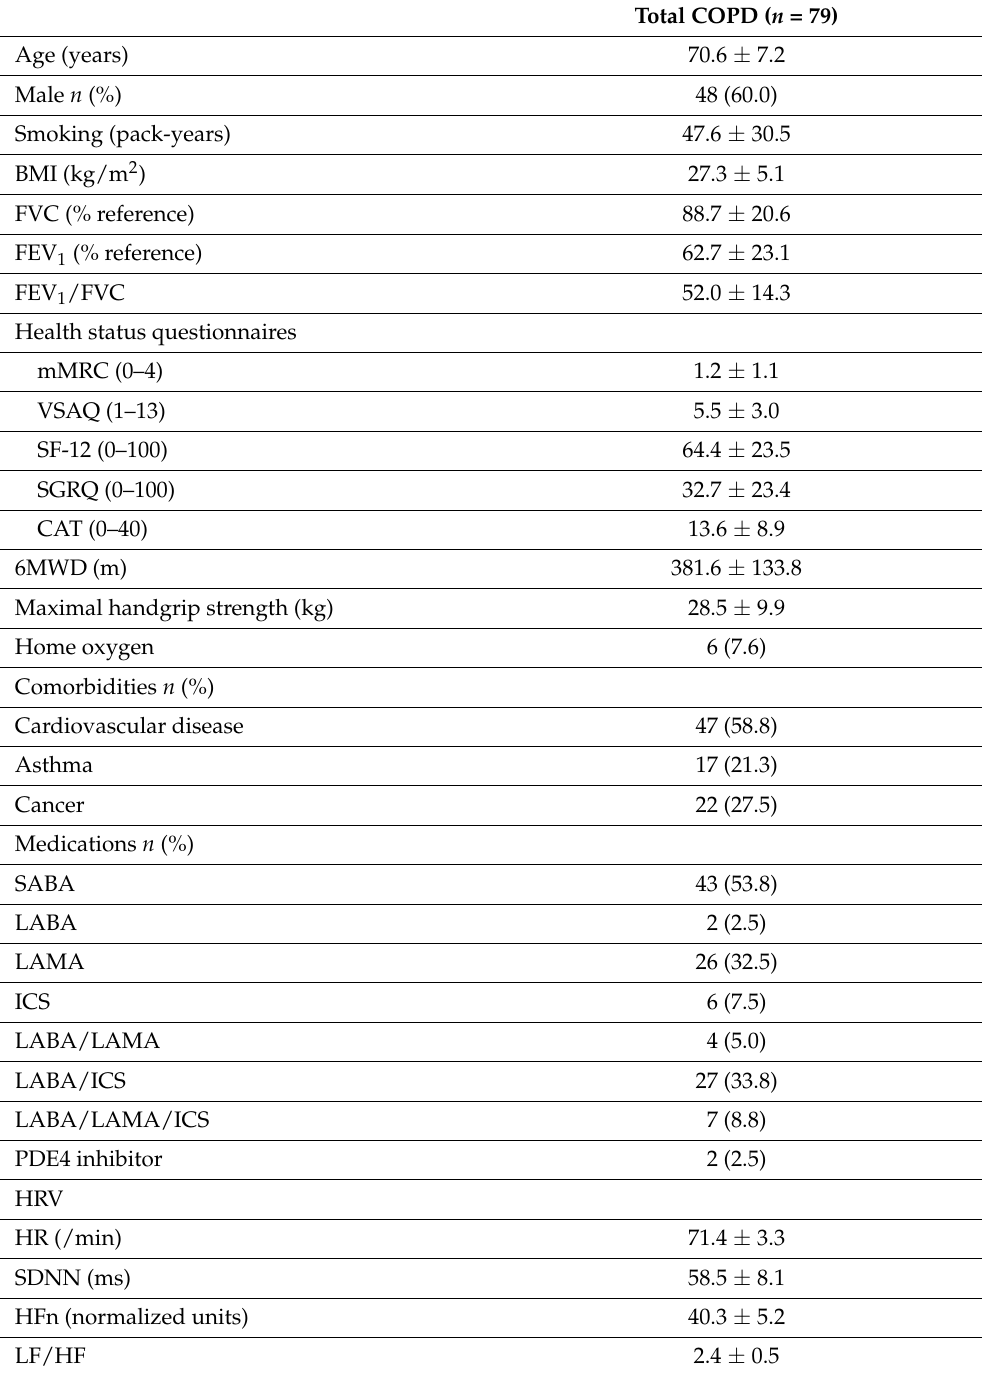
Table 1. Baseline demographics of patients with